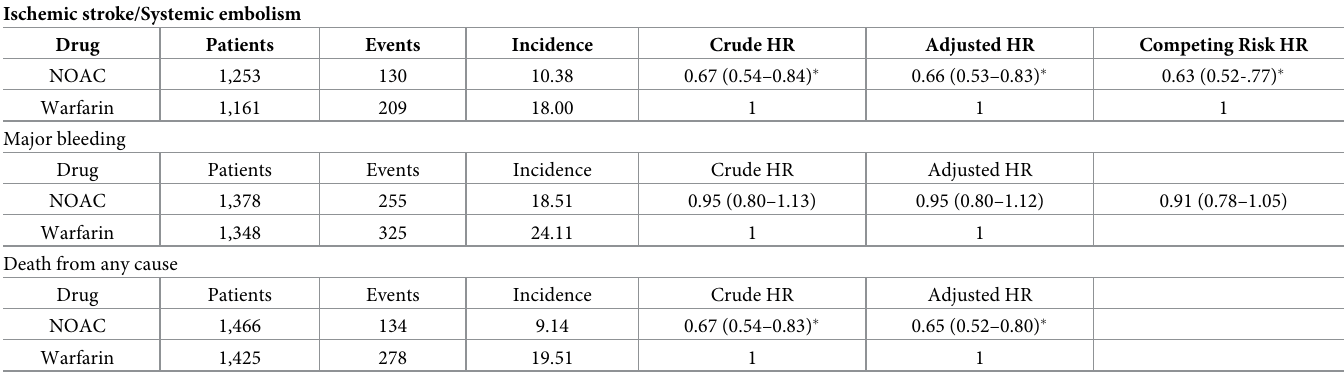
Table 2. Hazard ratios for outcomes in patients with